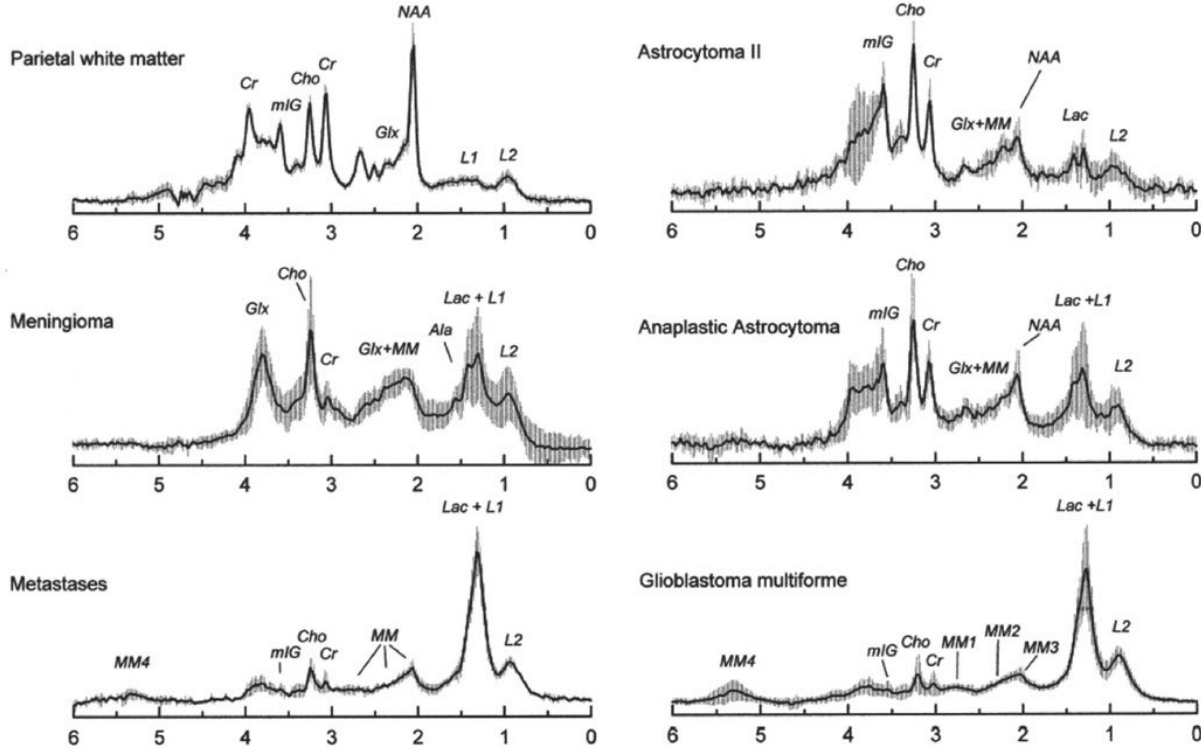
Figure 12. Spectra of normal brain tissue (parietal white matter) compared to tumors. The increased choline and decreased or absent NAA in the tumors is well demonstrated. Cr is tCr, mIG is myo-Inositol, Cho is tCho, Glx is glutamate plus glutamine, NAA is N-acetyl aspartate, L1 and L2 are lipids, Lac is lactate, MM is macromolecules, Ala is alanine which is characteristic of meningiomas.